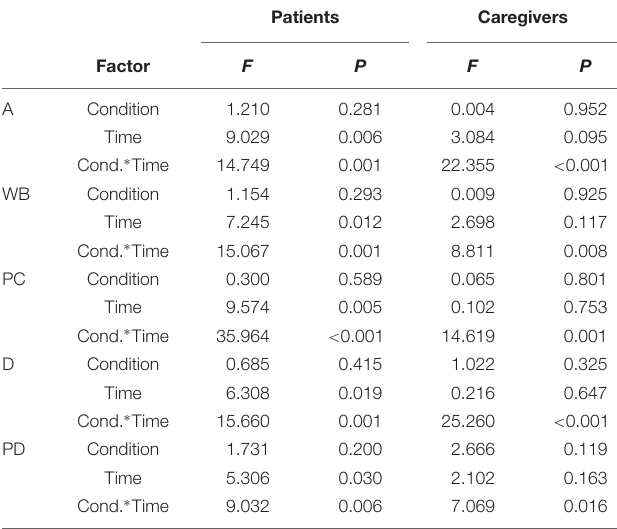
TABLE 3 | ANOVA calculated for treatment and control groups of patients and caregivers.